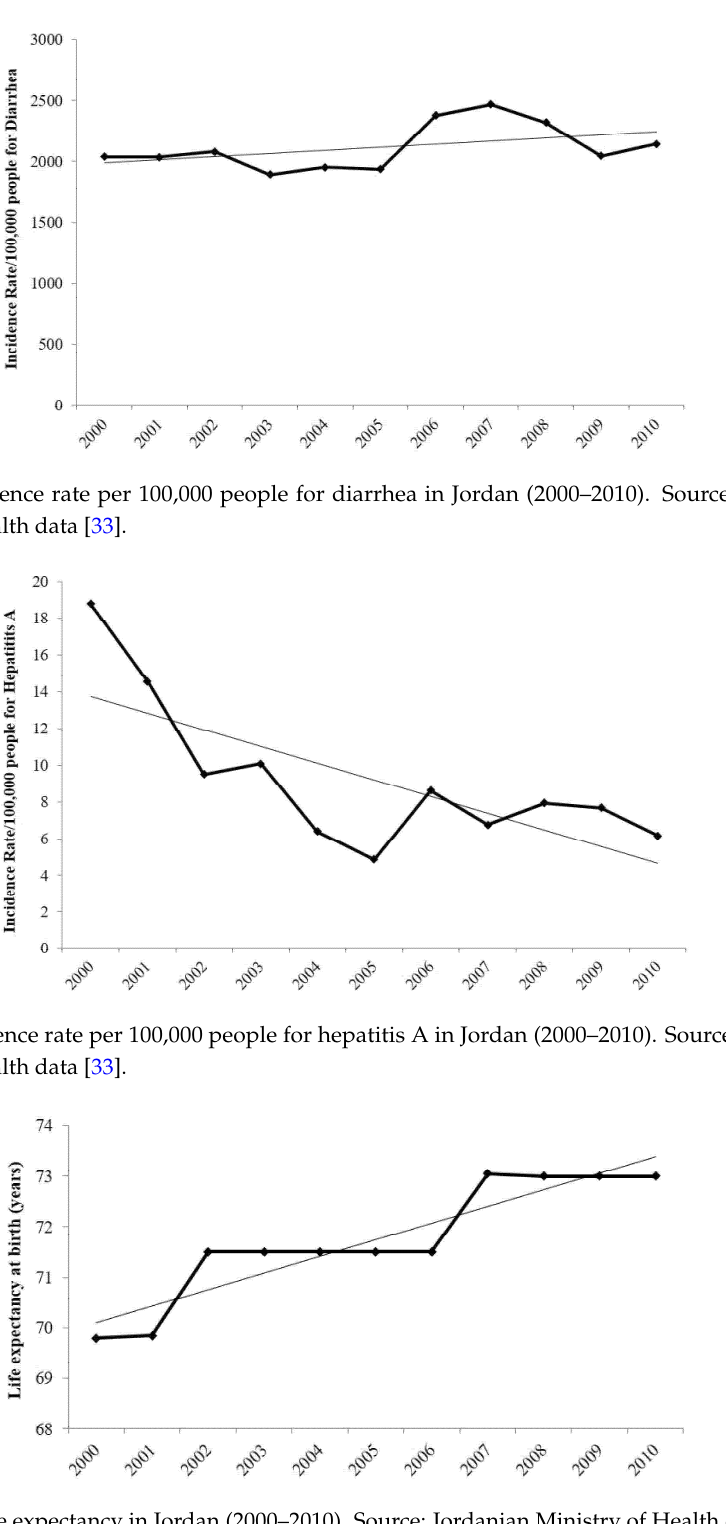
Figure 3. Life expectancy in Jordan (2000–2010). Source: Jordanian Ministry of Health data [33].